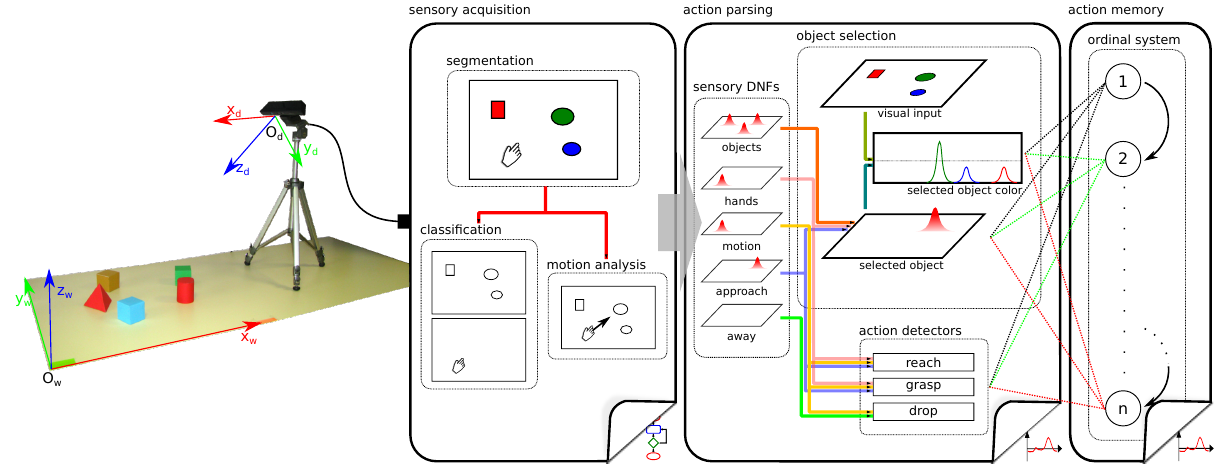
Figure 2: Overview of the architecture. The architecture receives sensory input about the scene from a Kinect (left). This input is fed to the algorithmic sensory acquisition module (left box). The core of the architecture, the DFT based action parsing system, is illustrated in the middle box. The right box shows the DFT based action memory system.